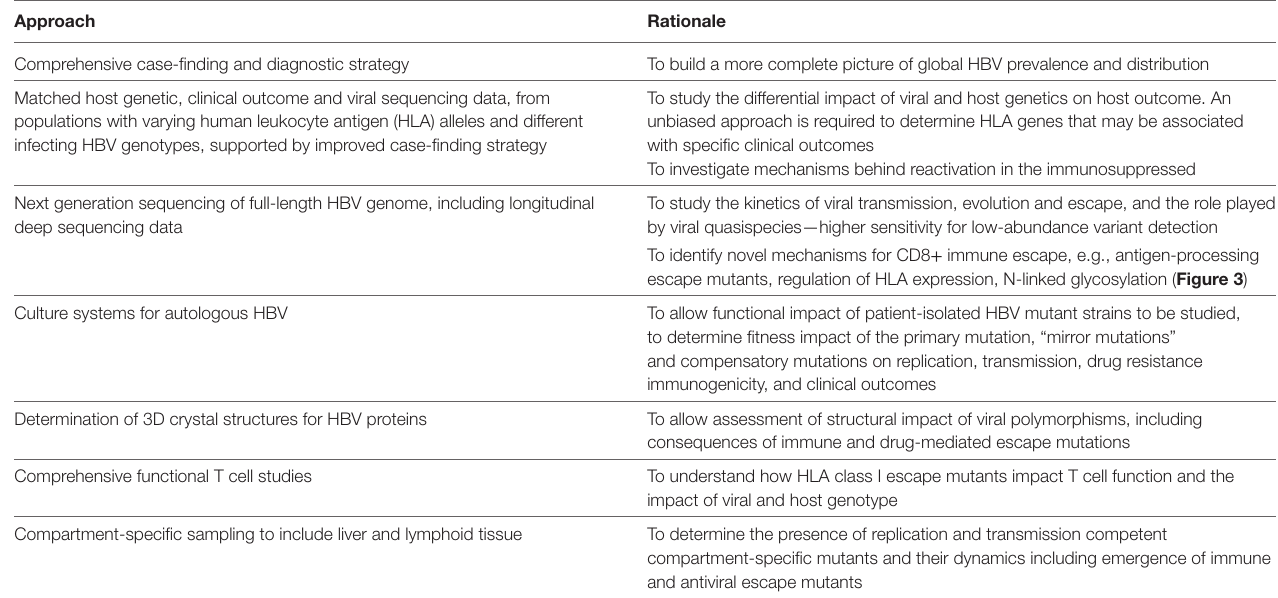
TABLe 2 | Areas for future focus in determining the nature and characteristics of the CD8 + T cell response to hepatitis B virus (HBV). Approach Rationale Comprehensive case-finding and diagnostic strategy To build a more complete picture of global HBV prevalence and distribution